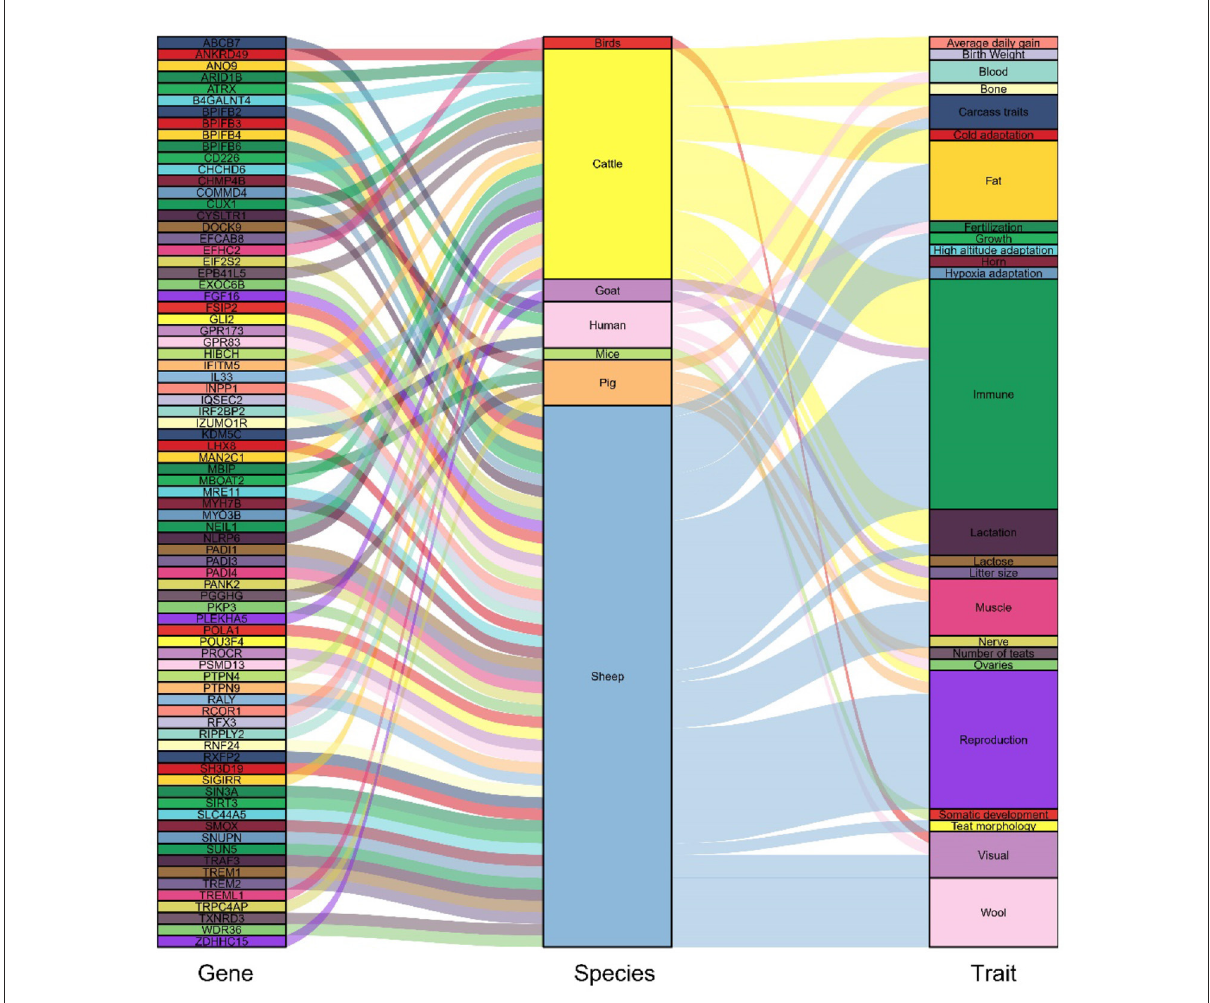
FIGURE5 Candidate genes previously reported to be highly associated with domestication and its